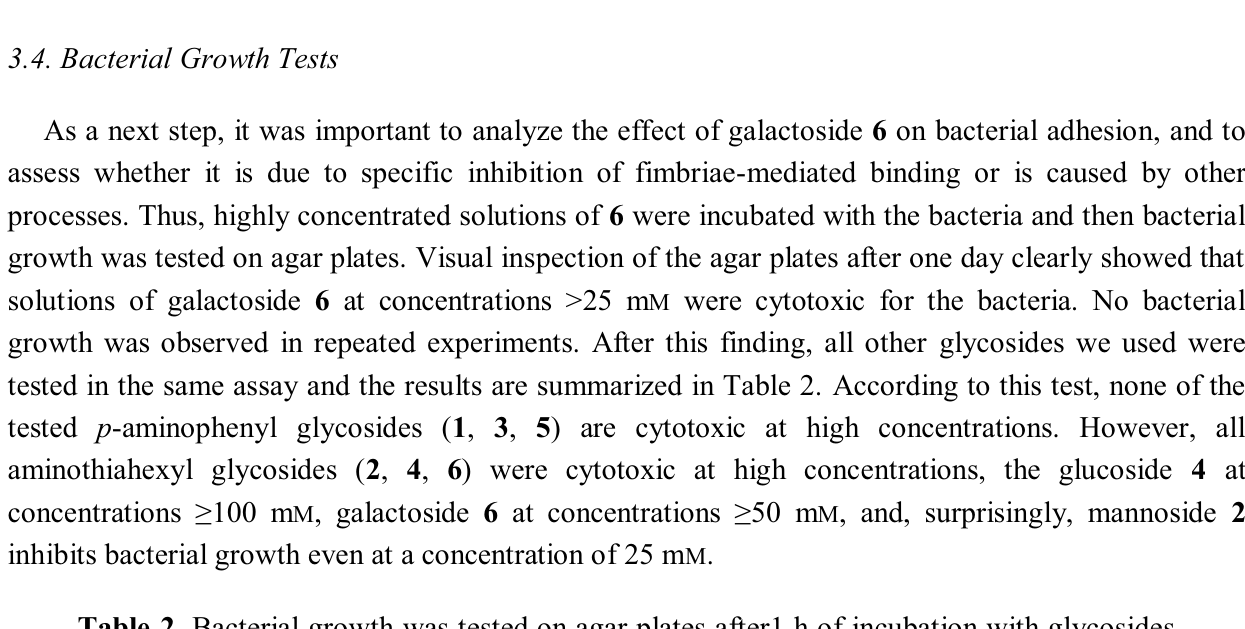
Table 2. Bacterial growth was tested on agar plates after1 h of incubation with glycosides 1 (cid:177) 6 , which were employed at the indicated concentrations. + Bacteria grow; (cid:237) no bacterial growth could be seen by visual inspection; n.t. not